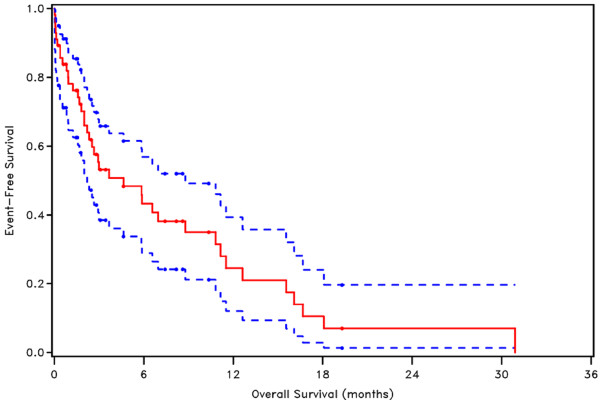
Kaplan Meier plot of overall survival with 95% confidence interval